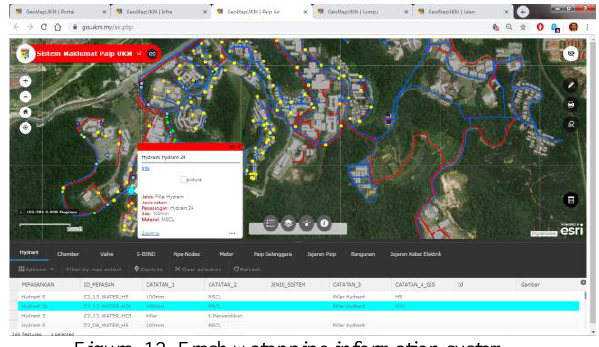
Figure 12. Fresh water pipe information system.